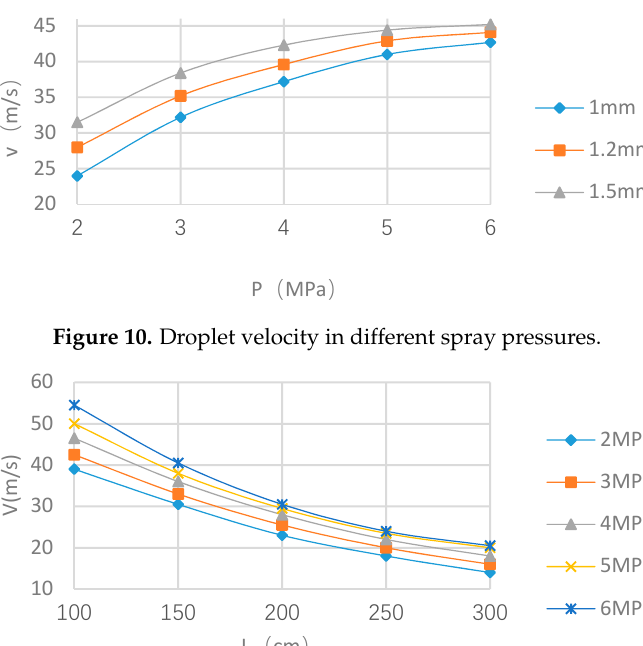
Figure 11. The axial distribution of droplet velocity.